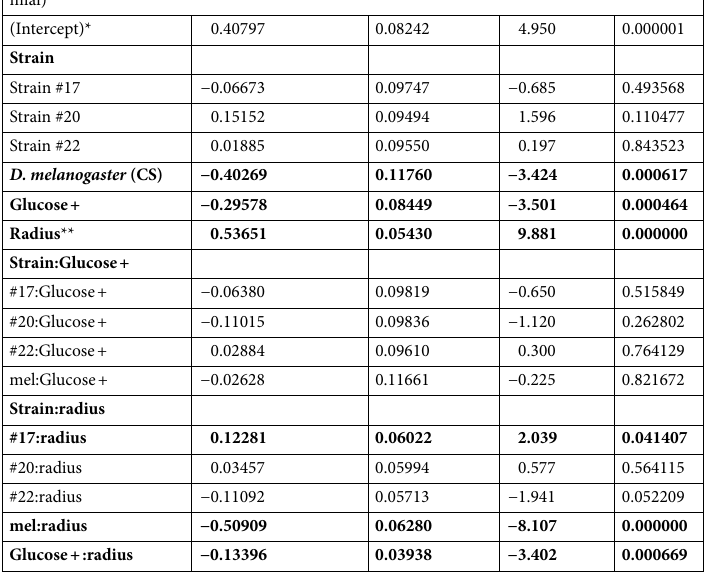
Table 3. Analysis of the result of two-choice assay. Significant values are in bold. *Strain #26 was assigned as a base strain (Intercept represents the preference of strain #26 in 5.7 vs. 4.8 without glucose). **Values for